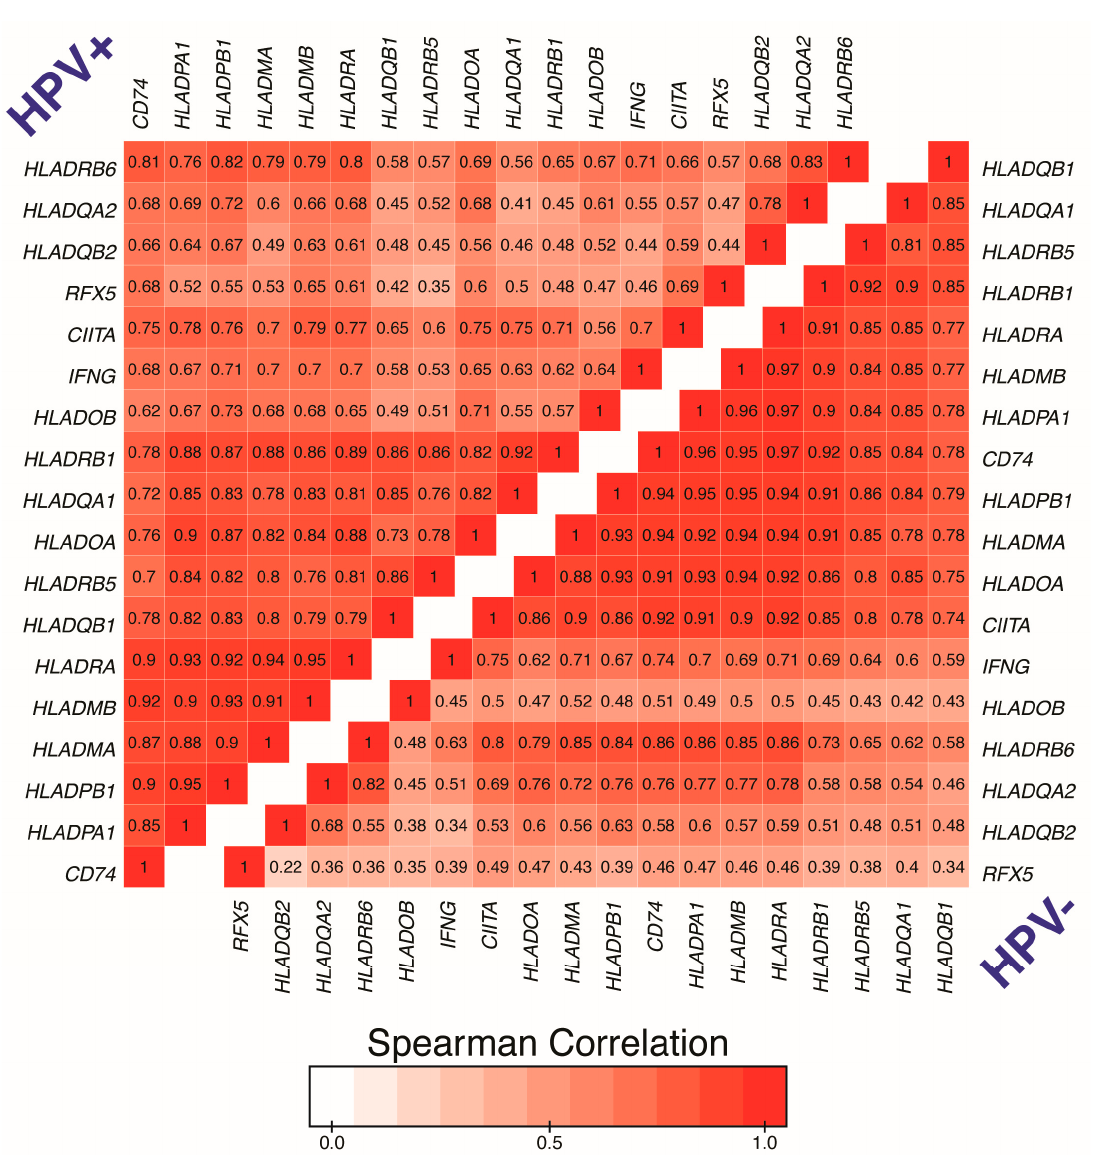
Figure 4. Correlation matrix of genes involved in the MHC-II antigen presentation pathway in head and neck carcinomas stratified by HPV-status. RSEM normalized RNA-seq data for the genes listed above were extracted from the TCGA database for the HNSC cohort for HPV + (upper triangle) and HPV − samples (lower triangle). Pairwise spearman correlation was performed followed by hierarchical clustering to group based on correlation. Number in boxes indicate Spearman’s rank correlation coefficient of analyzed gene pairs.